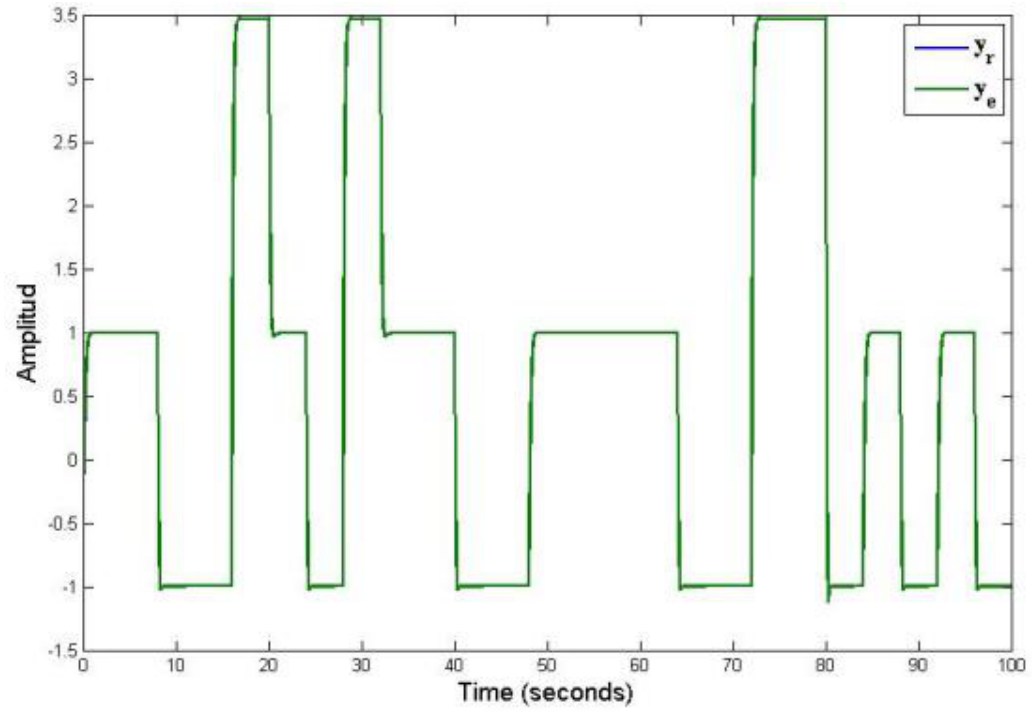
Figure 4. Output of the observer in piecewise a linear system, known and arbitrary commutation